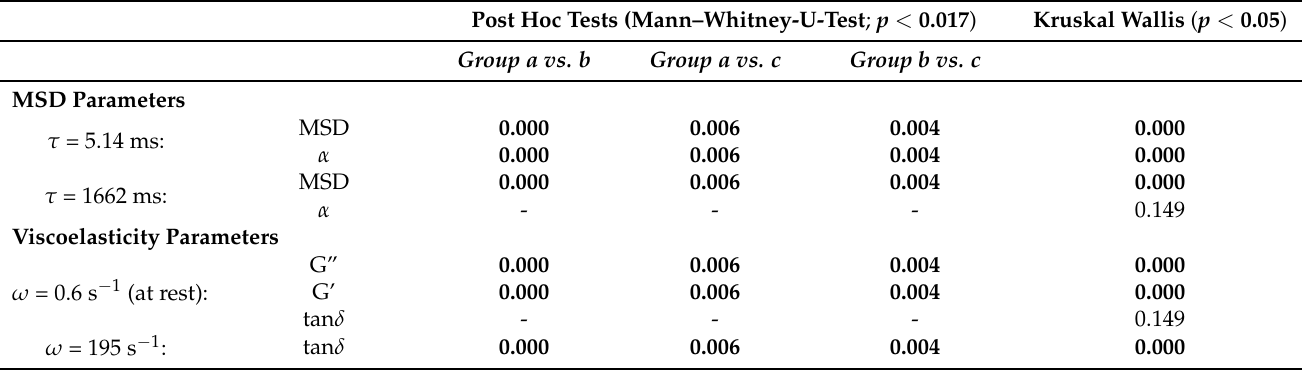
Table 3. Statistical analysis of characteristic MSD and viscoelasticity parameters. Differences were found for all parameters except the diffusive exponent α at the higher and the tan δ at the lower evaluation limit and comparison of all groups. Post Hoc Tests (Mann–Whitney-U-Test ; p < 0.017